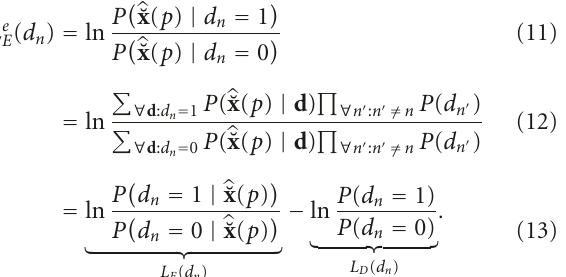
Figure 3: The turbo receiver for Q-OFDMA